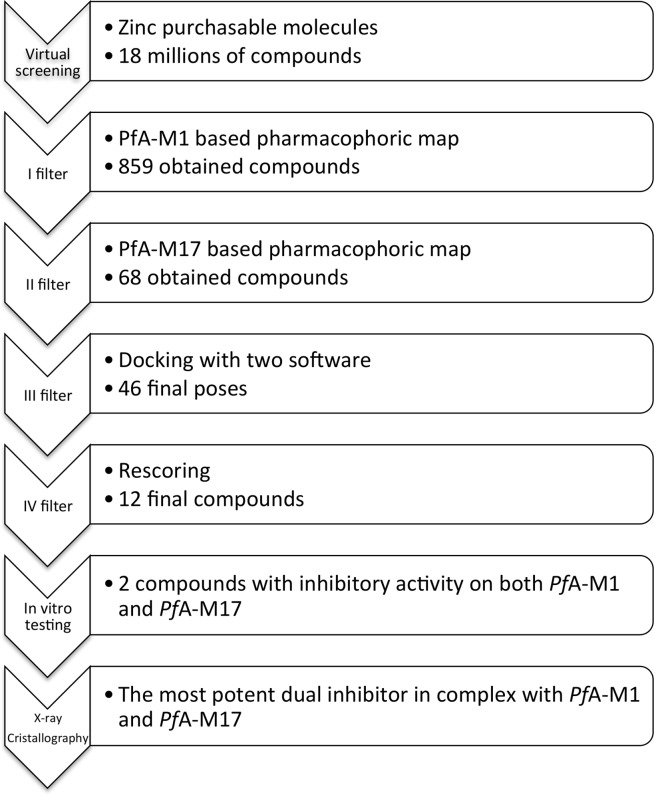
Virtual screening workflow.